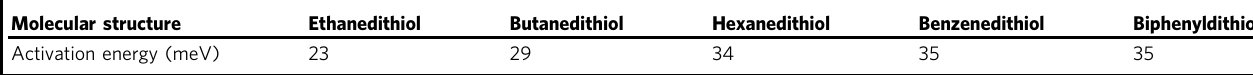
Table 2 Activation energies extracted from Arrhenius plots shown in Fig. 3c, d. Molecular